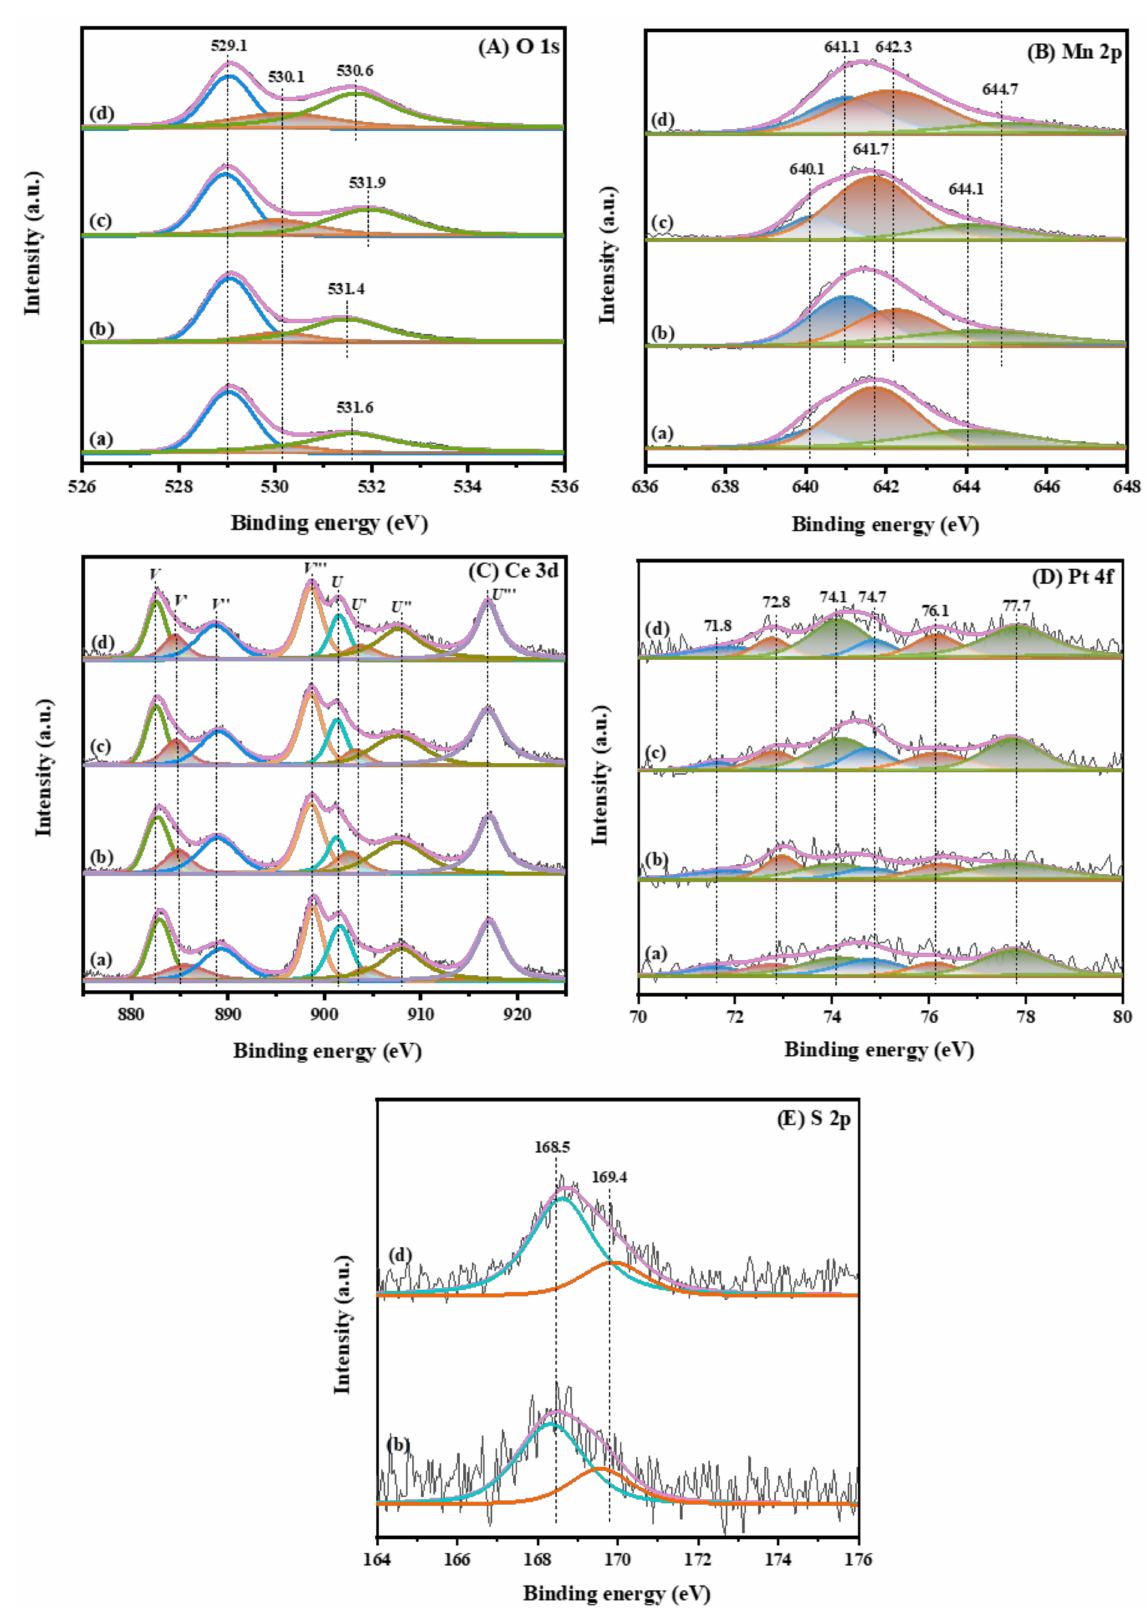
Figure 9. ( A ) O 1s, ( B ) Mn 2p, ( C ) Ce 3d, ( D ) Pt 4f, and ( E ) S 2p XPS spectra of (a) fresh Pt/CeMnO x